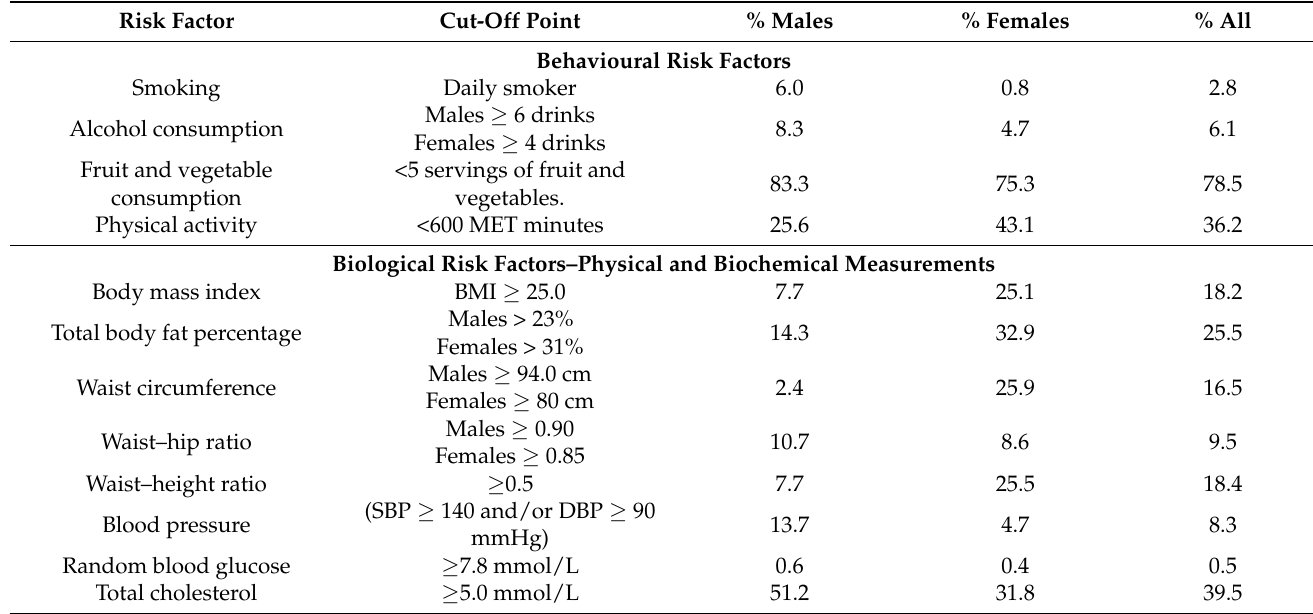
Table 4. Percentage of participants who showed risk factors of chronic diseases of